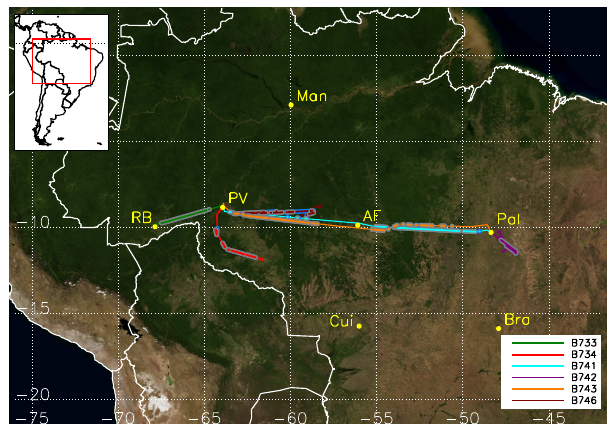
Figure 1. Ground tracks for the six research flights listed in Table 1. The location of the valid lidar profiles used for the computation of aerosol extinction is highlighted as follows: grey, profiles that pass our quality control test; blue, remaining profiles. The follow- ing locations are also shown: Porto Velho (PV), Rio Branco (RB), Alta Floresta (AF), Palmas (Pal), Manaus (Man), Cuiabà (Cui), and Brasilia